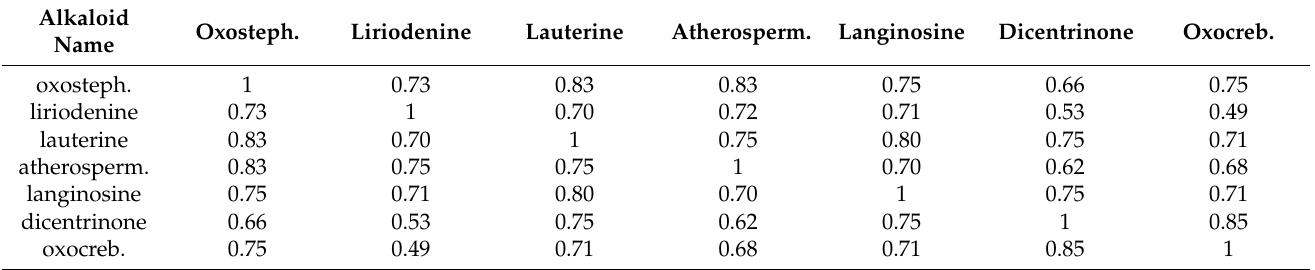
Table 5. Structural similarities among oxostephanine and other